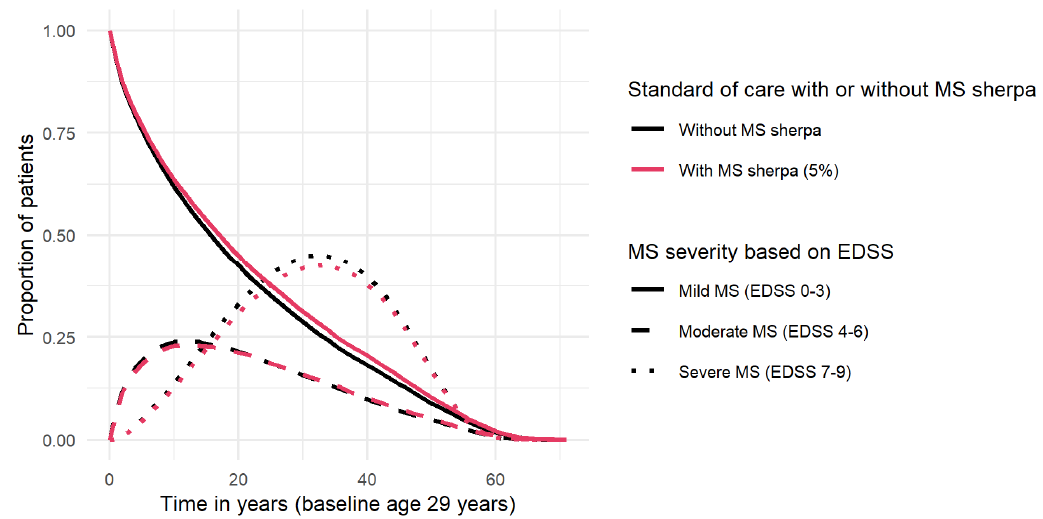
Figure 3. Progression in MS severity over time measured with EDSS over time, with and without use of MS Sherpa.